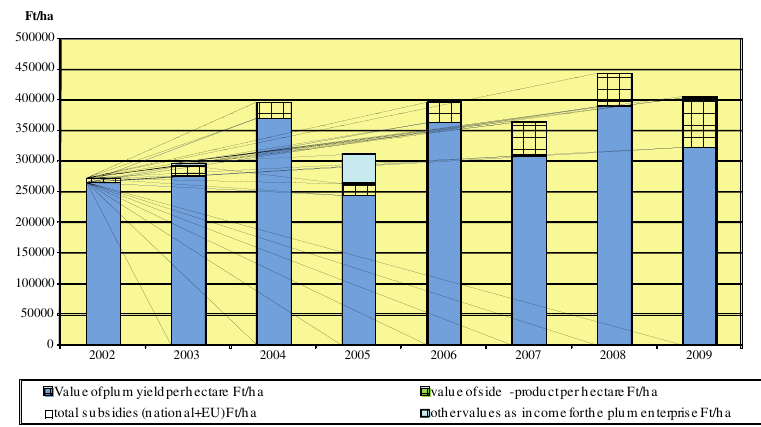
Figure 1. Values produced by plums growers in farms relevant on the Hungarian markets